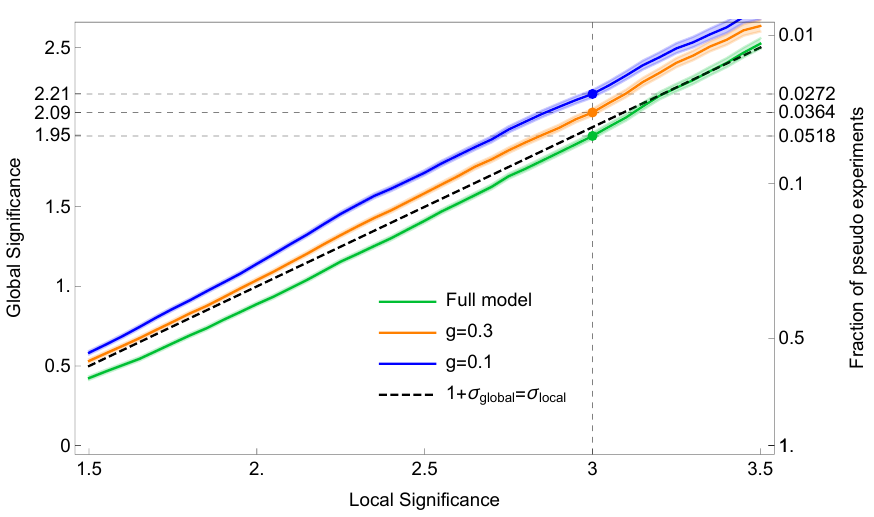
Figure 10 . Fraction of CMS036 pseudo-experiments (generated from background counts reported in [12]) with a global signi(cid:12)cance (anywhere on the mass grid of the mono- (cid:30) model) above a speci(cid:12)ed local signi(cid:12)cance threshold. The axis on the right shows this fraction, while the axis on the left indicates its equivalent standard normal distribution signi(cid:12)cance. The green line denotes the fraction of 10,000 pseudo-experiments that have a given local signi(cid:12)cance in the full parameter space of the model, while the orange and blue lines represent the global signi(cid:12)cance for particular choices of g . The excess in the real data lies on the vertical line at (cid:27) local (cid:25)